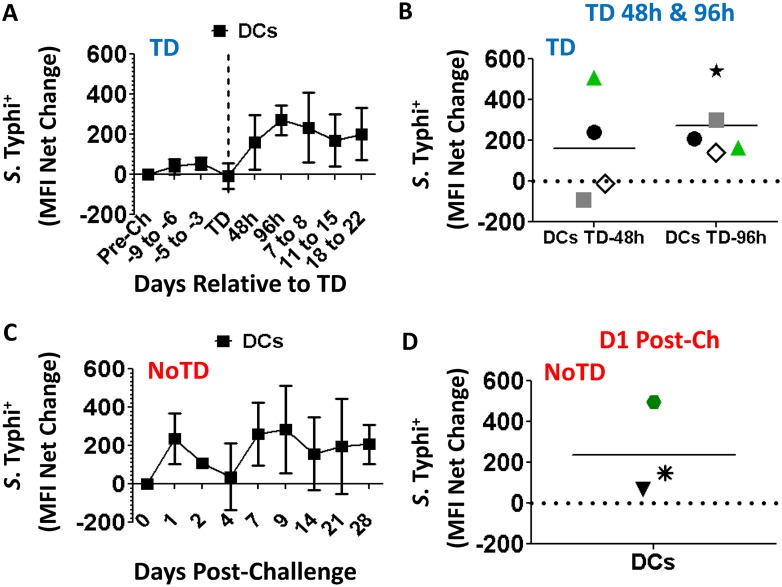
Ability of DCs to bind S. Typhi following wild-type challenge.Time courses of the binding ability of circulating DCs from TD (A) and NoTD (C) volunteers for S. Typhi (killed-fluorescently labeled). Shown in panels B and D are the data of individual volunteers at peak time of binding in TD (TD-48h and TD-96h) and NoTD (D1 Post-challenge) volunteers, respectively. Each volunteer is indicated by a defined symbol and color, as in Fig 4. The horizontal line indicates the means.